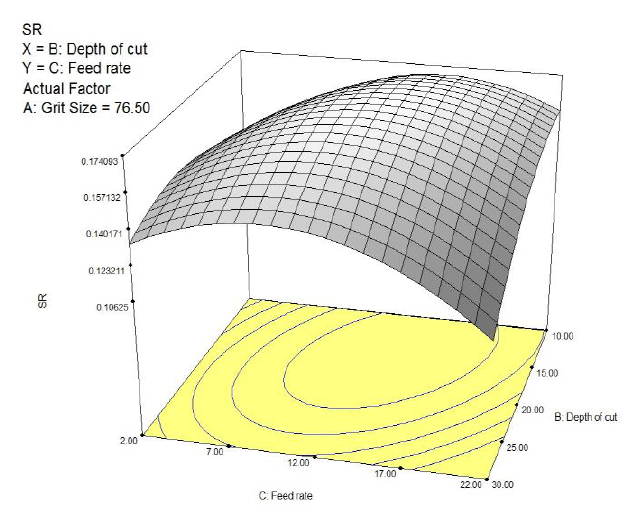
Figure 11: The 3D plot of the interaction effect of feed rate and depth of cut.